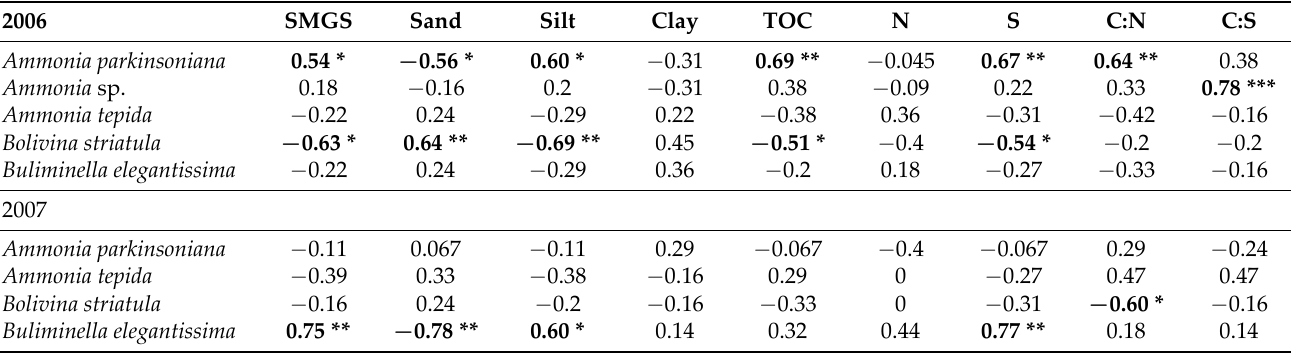
Table 1. Correlation between the main species relative abundances (>4%) and environmental pa‑ rameters in the sediment (Kendall’s coefficient of rank correlation, τ ). Significant correlations